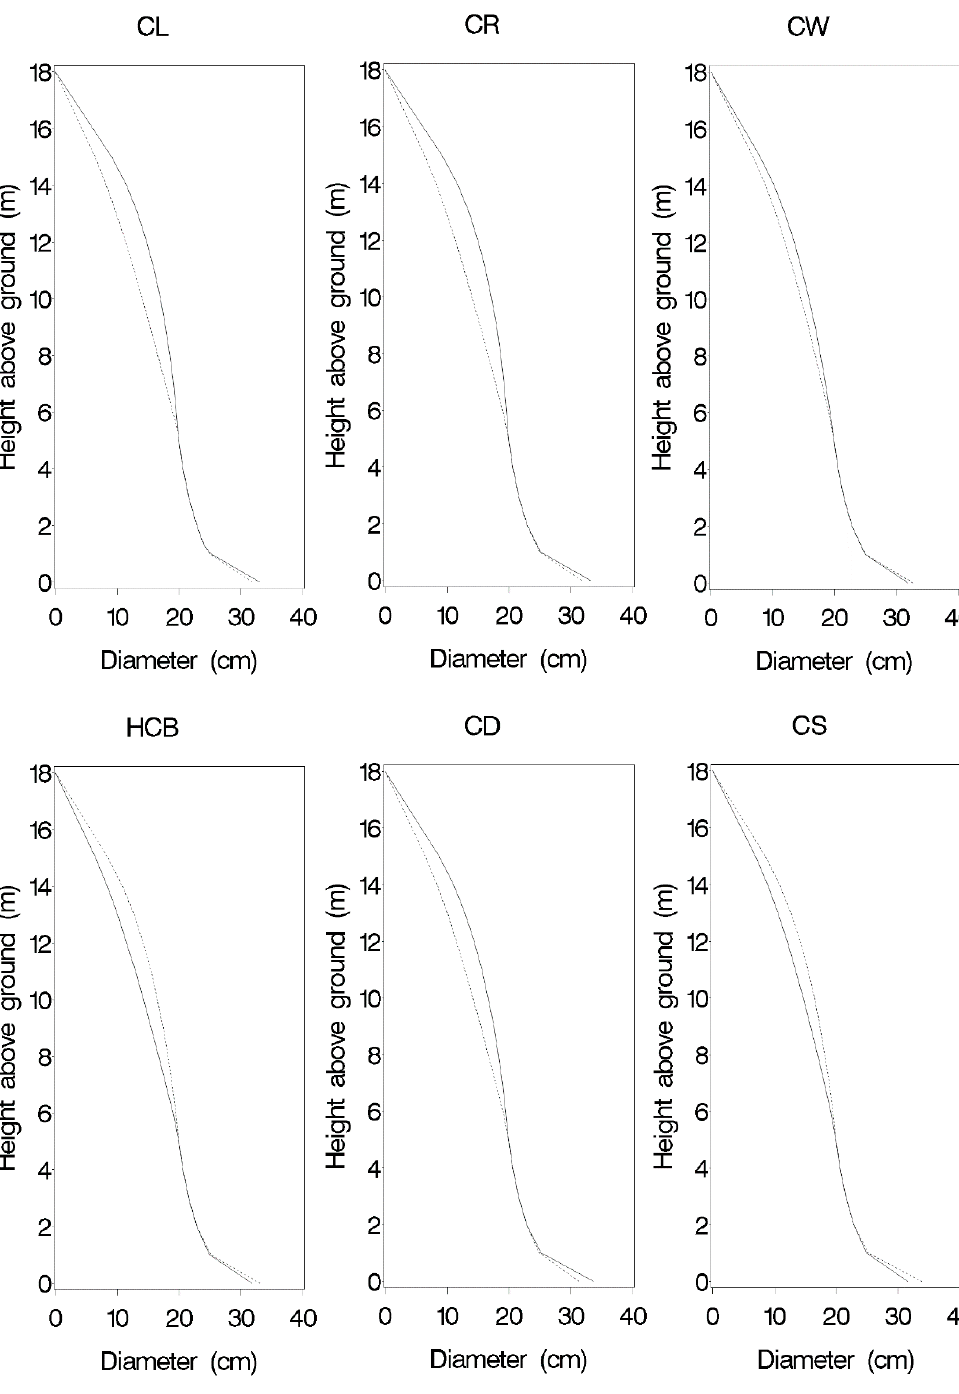
Figure 5. Tree profiles generated from the Clark model with crown variables with the same values of diameter at breast height (DBH) (24.0 cm) and total height (18.0 m) by the different values of crown leangth (CL) (4 and 14 m), crown ratio (CR), (0.2 and 0.7), crown width (CW), (2 and 10 m), Height to live crown base (HCB), (5 and 15 m), crown base diameter (CD), (5 and 28 cm), crown shape (CS), (0.3 and 1.4) for Dahurian larch.